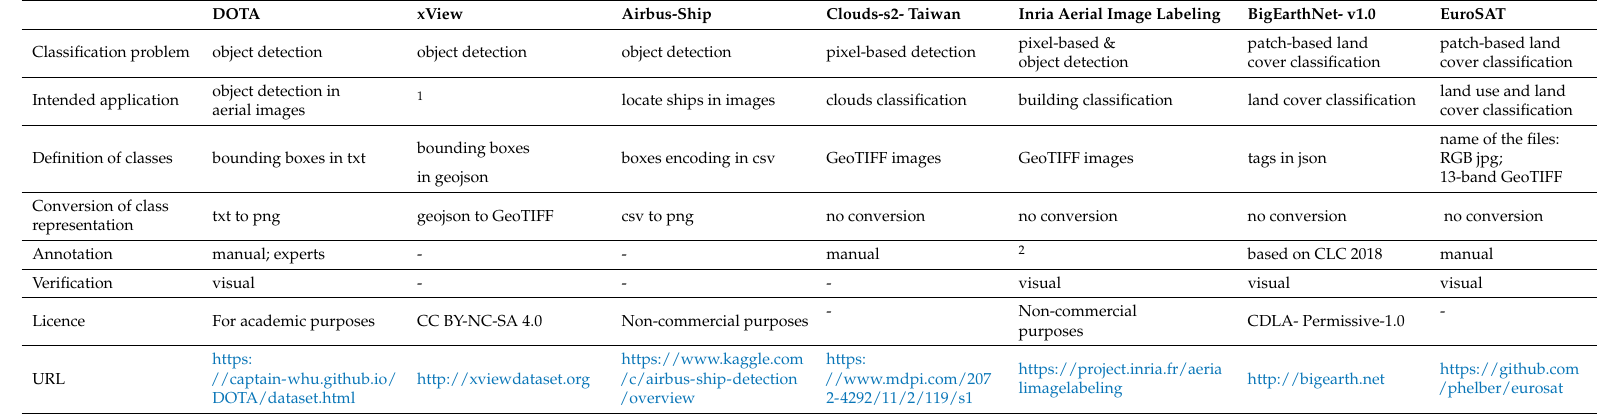
Table 1. Attributes related to the scope of the training data.